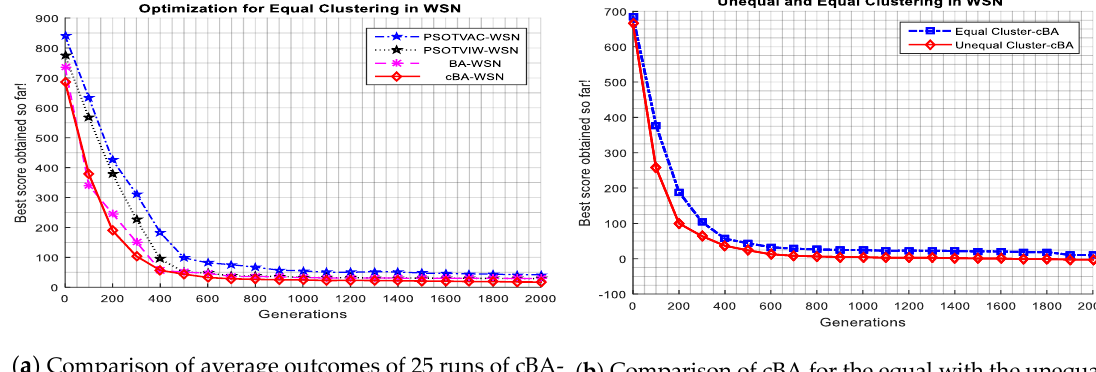
Figure 5. Two scenarios of clustering and unequal clustering methods in WSNs.